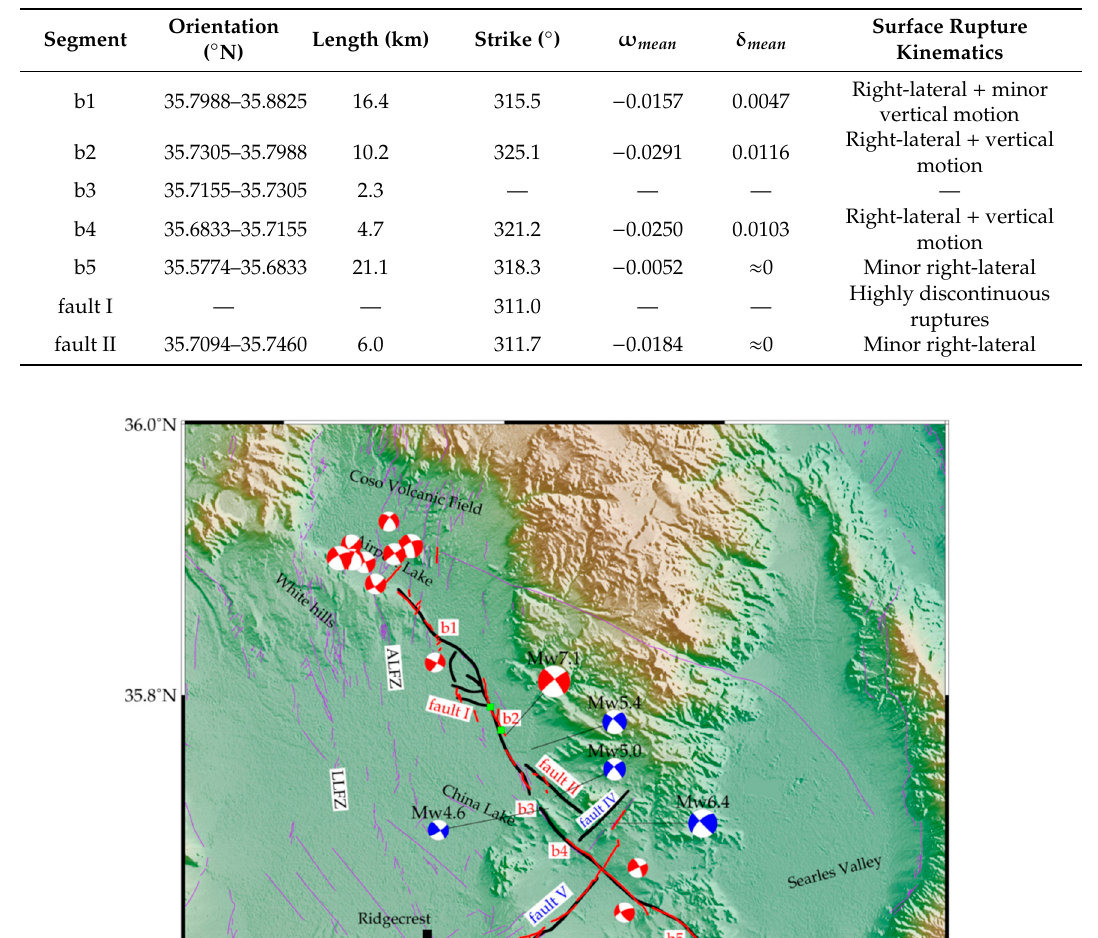
Table 1. The geometry and rupture kinematics of multiple faults derived from curl and divergence. Segment